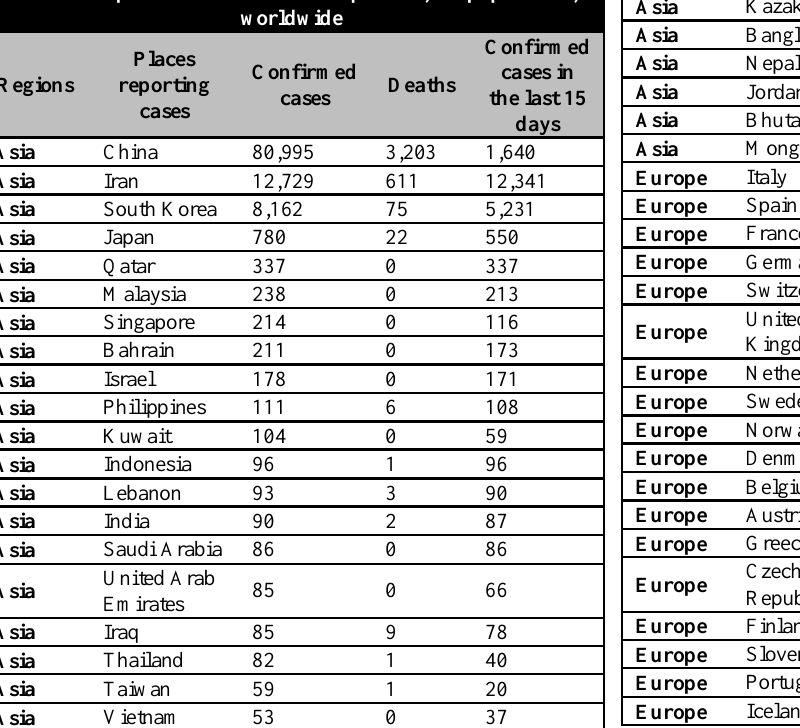
Table 1. Reported COVID-19 cases per 100,000 population,